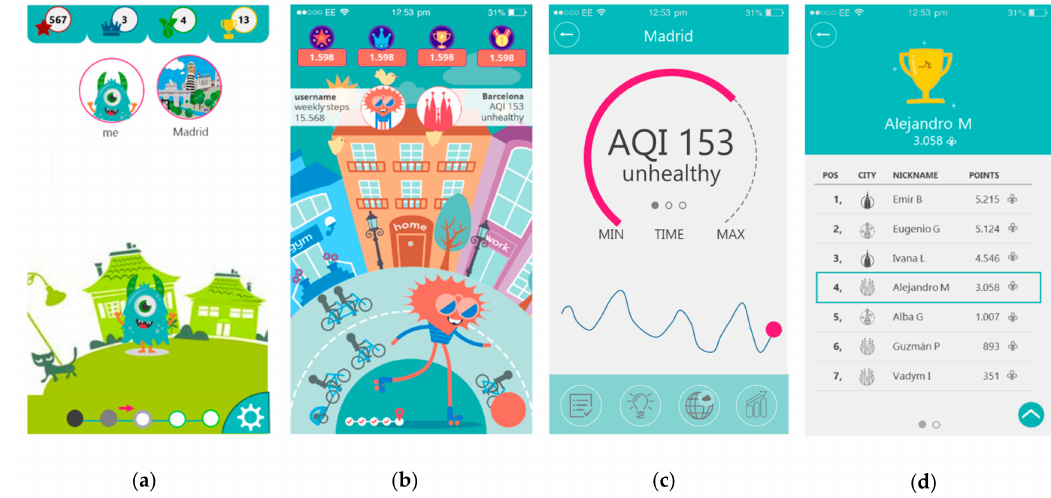
Figure 2. PulsAir mobile application mockup interface designs: ( a ) Home Menu, first version; ( b )